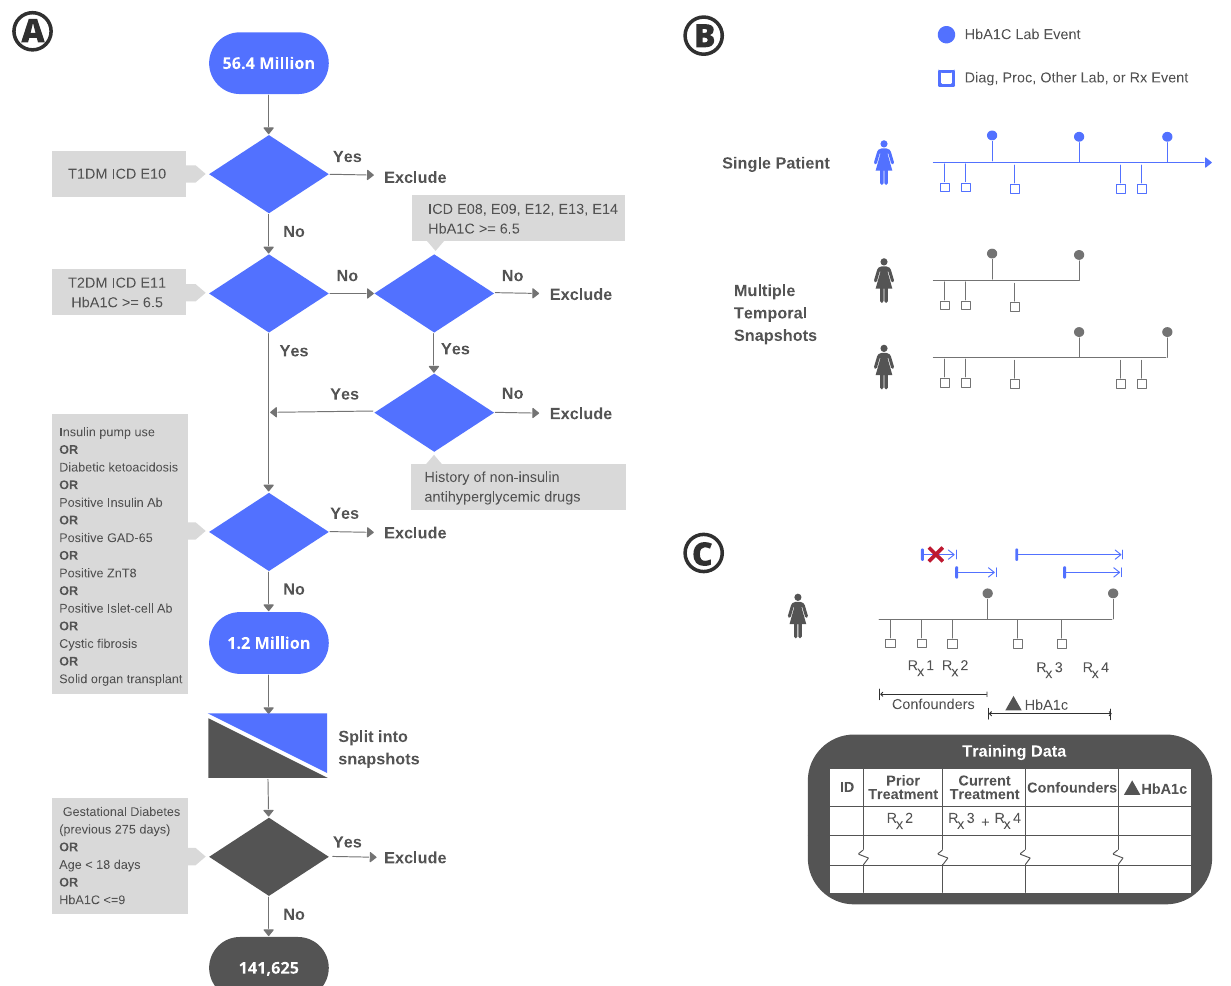
Fig. 1 | Study cohort de fi nition and data preparation. a Clinical fi lters were designed to identify patients with T2DM (1.2 million individuals) and retain only those with well-established, high-risk disease. b Each patient ’ s health history was split into a series of temporal snapshots, determined by an HbA1c ≥ 9% lab mea- surement and ending at the subsequent HbA1c for each patient. A snapshot con- sisted of a pair of HbA1c lab events. The fi rst of these is referred to as the index HbA1c lab event and the period between the two lab events is the observation period. Only snapshots where the duration between the lab pairs was between 90 and 365 days were retained and the rest were excluded, resulting in a fi nal study